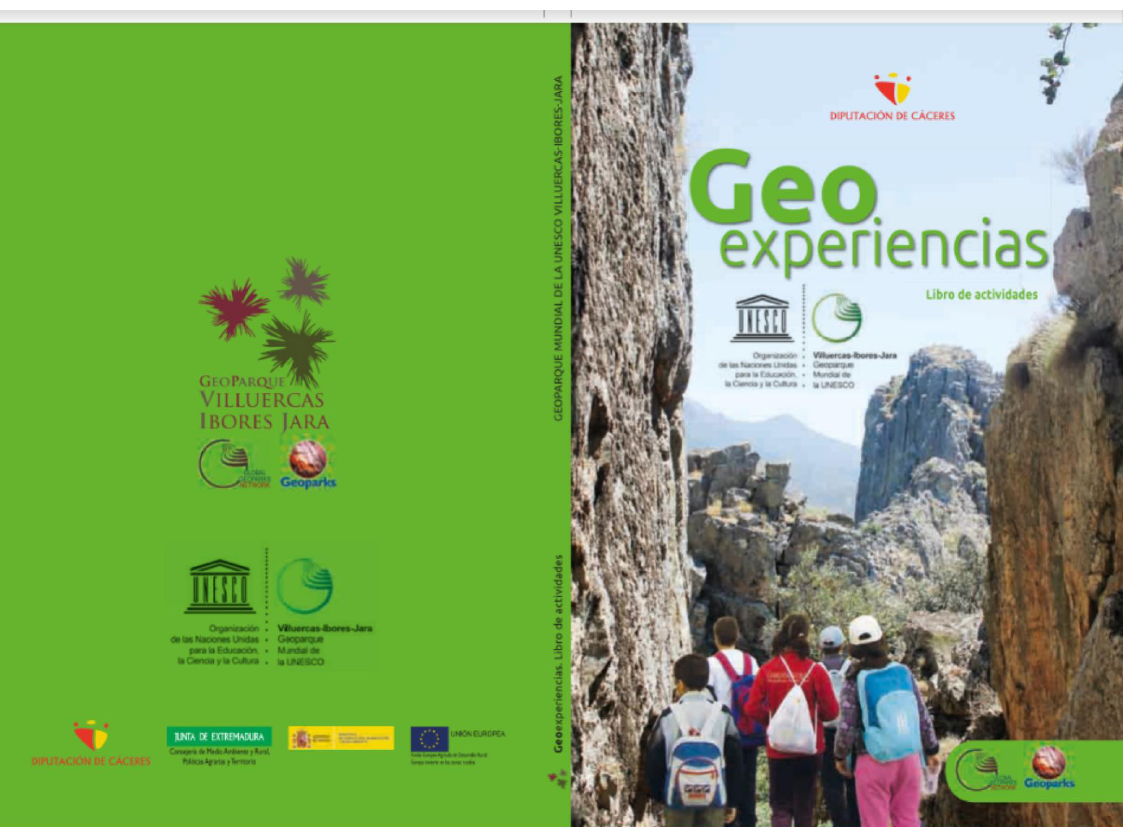
Figure 8. Villuercas Ibores Jara Geopark activities textbook cover (Image from: https://shre.ink/hmT).